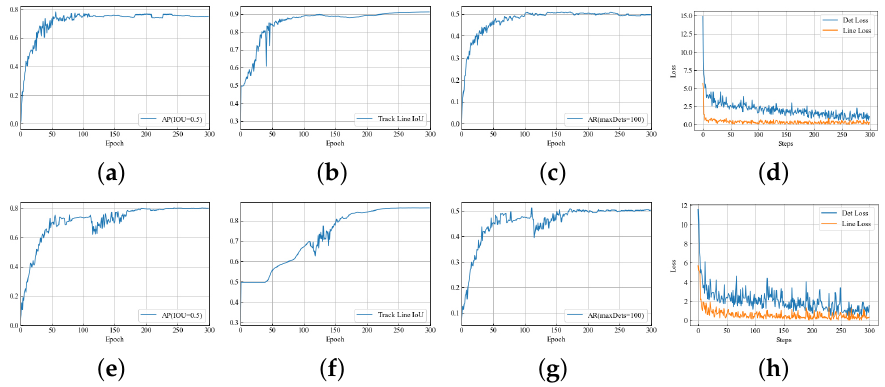
Figure 7. The training results of this network. ( a ) mAP@50 without processing the task weight coefficient. ( b ) mIoU without processing the task weight coefficient. ( c ) Recall without processing the task weight coefficient. ( d ) Loss without processing the task weight coefficient. ( e ) mAP@50 with the adaptive weight proposed by this network. ( f ) mIoU with the adaptive weight proposed by this network. ( g ) Recall with the adaptive weight proposed by this network. ( h ) Loss with the adaptive weight proposed by this